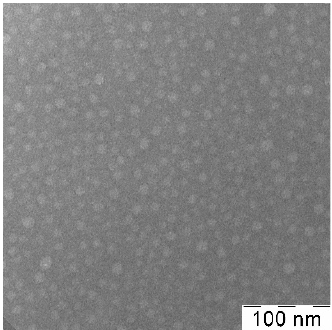
Figure 3. TEM image of copolymer 1 from the aqueous solution.